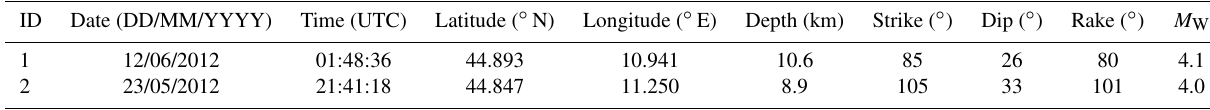
Table 3. Parameters of the two simulated seismic events.